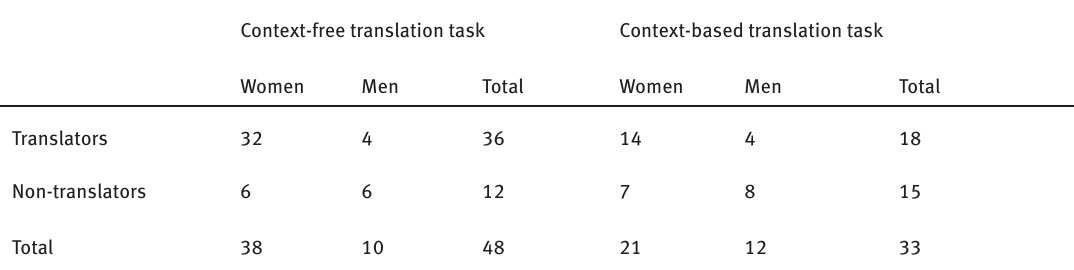
Table 2: Participants in the colour metaphor translation